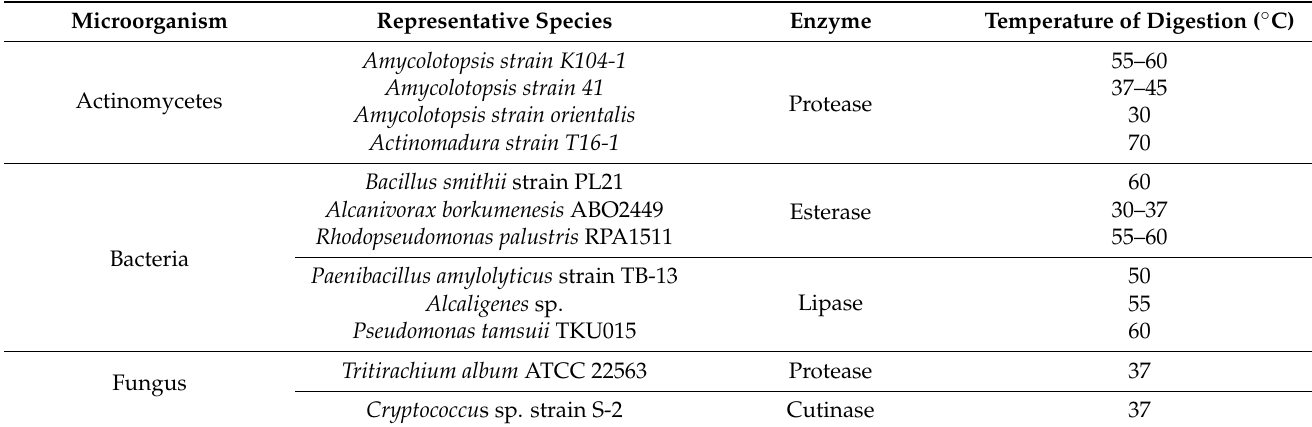
Table 1. Microorganisms and enzymes degrading PLA with the temperature of the mineralization process [41].